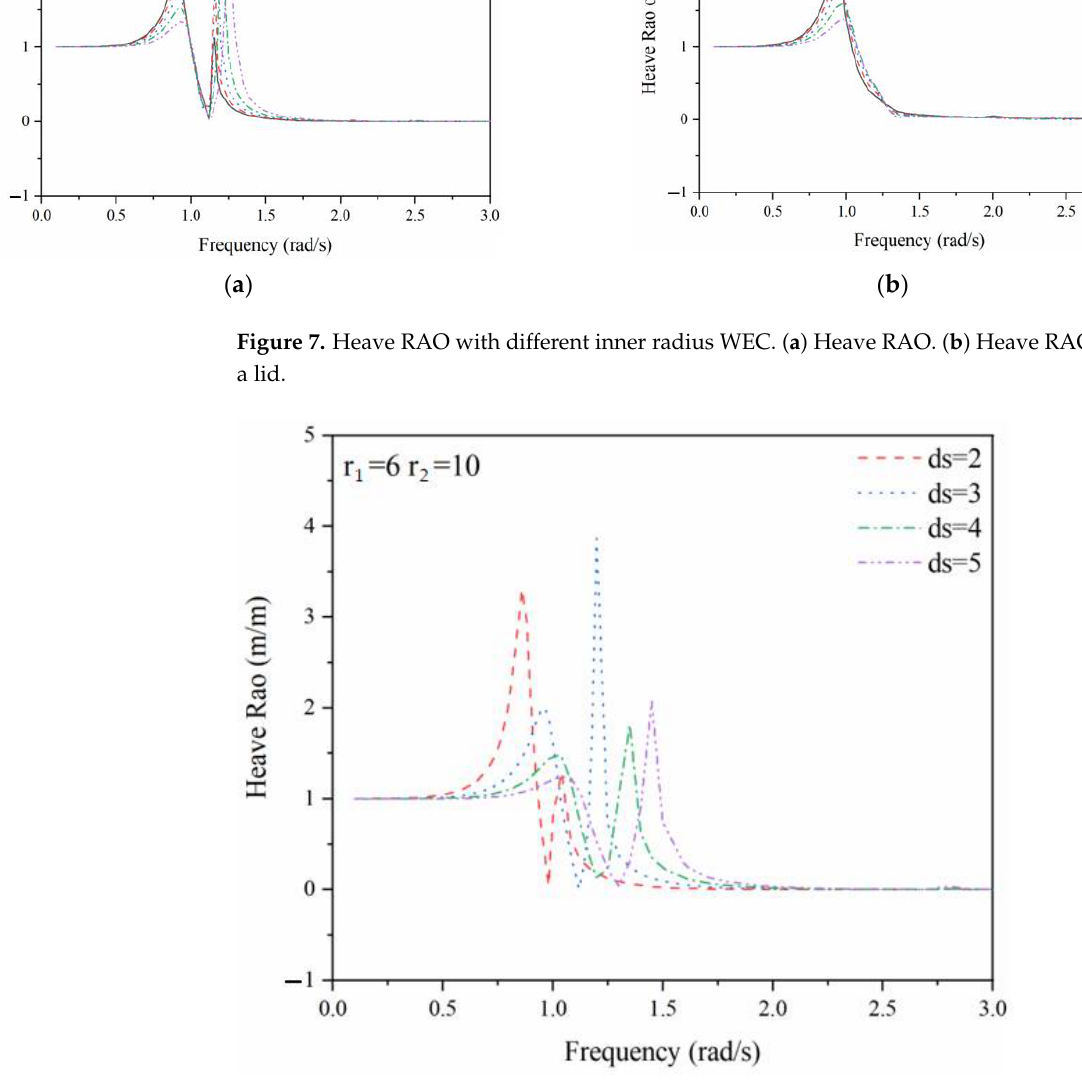
Figure 7. Heave RAO with different inner radius WEC. ( a ) Heave RAO. ( b ) Heave RAO after add- ing a lid.